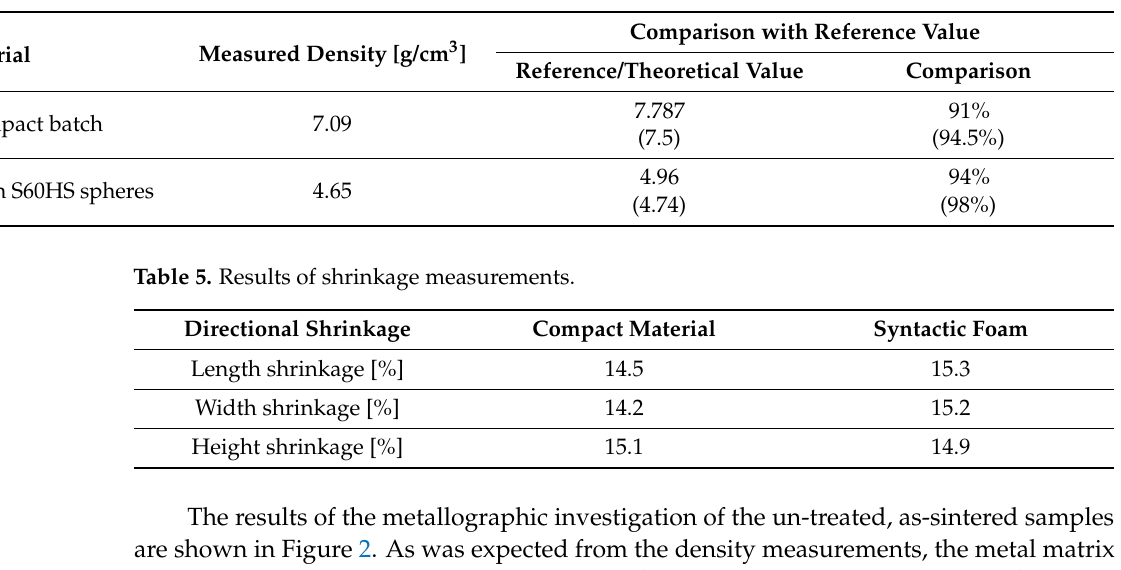
Table 4. Results of the density measurements.